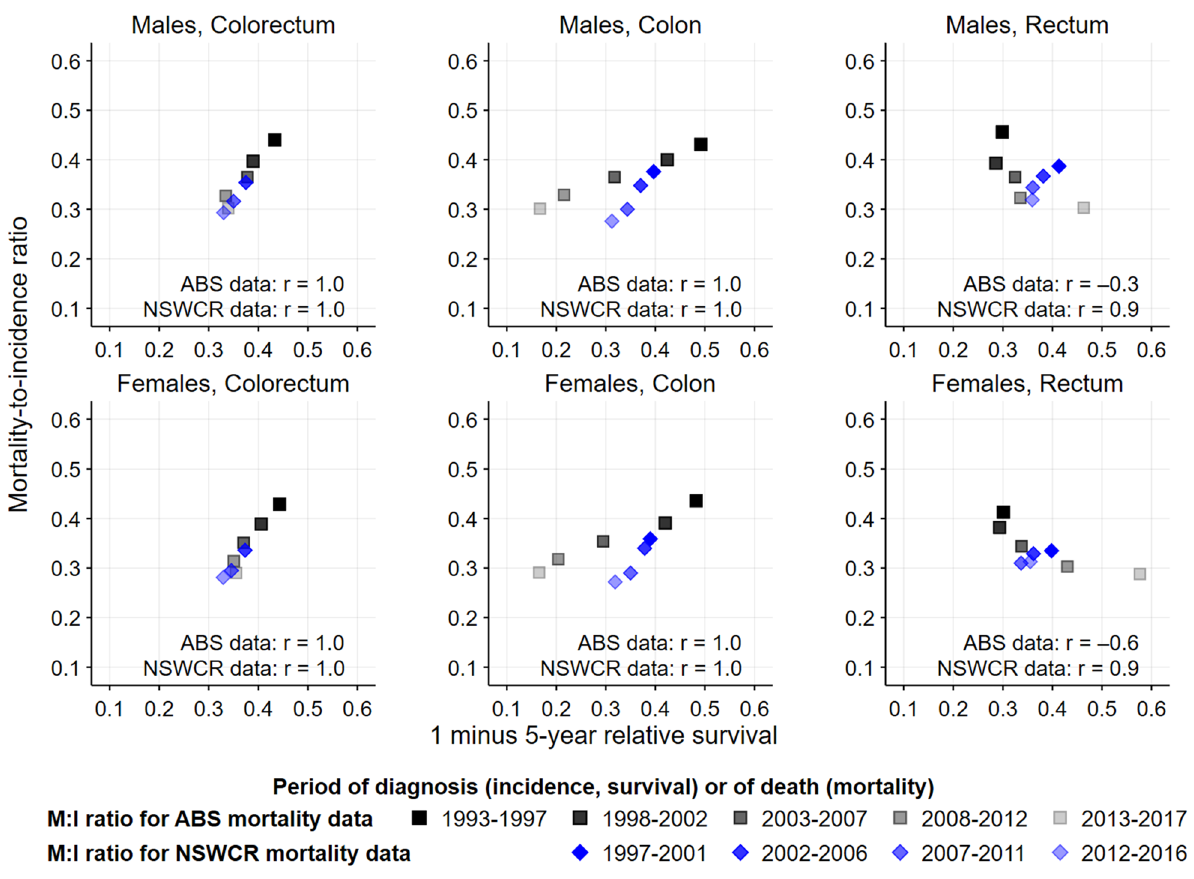
Figure 1. Comparison of mortality-to-incidence ratio (M:I ratio) and (1 minus 5-year relative survival) for colon and rectal cancers in Australia using mortality data from the Australian Bureau of Statistics (ABS) and the New South Wales Cancer Registry (NSWCR). r denotes the correlation coefficient. The M:I ratio for the ABS mortality data used incidence data from the Australian cancer registries (Reference: Australian Institute of Health and Welfare (AIHW) 1 ). The M:I ratio for the NSWCR mortality data used the NSWCR incidence data. Some validation of the NSWCR mortality data is partially based on pathological reports and other medical records received by the NSWCR, so the NSWCR mortality data are not completely independent of the incidence